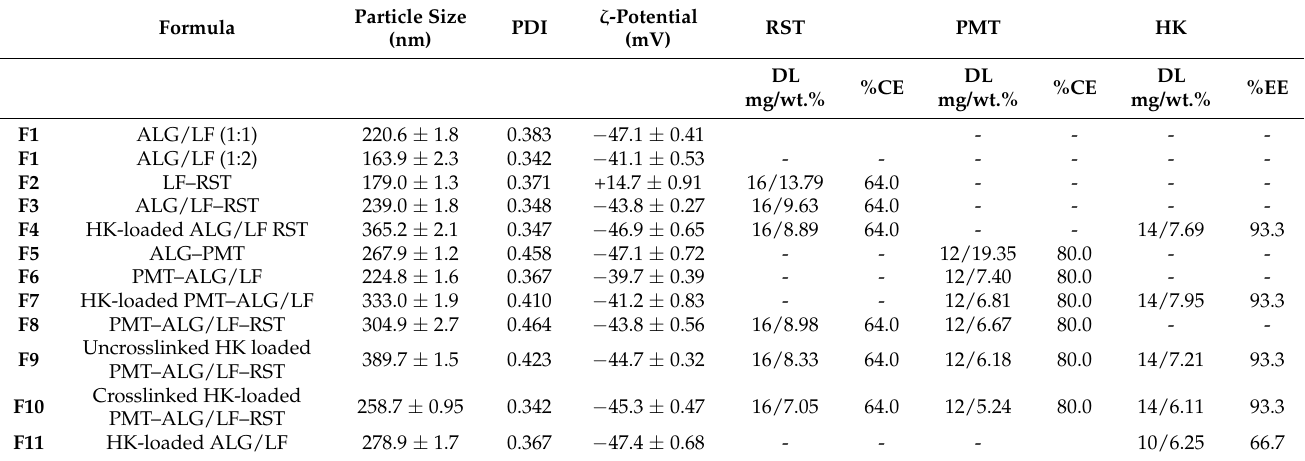
Table 1. Physicochemical characteristics and composition of crosslinked HK/PMT–ALG-LF–RST NHs. Zeta potential, particle size, entrapment efficiency (EE), drug loading (DL) and conjugation efficiency (CE %) of NPs ( n =